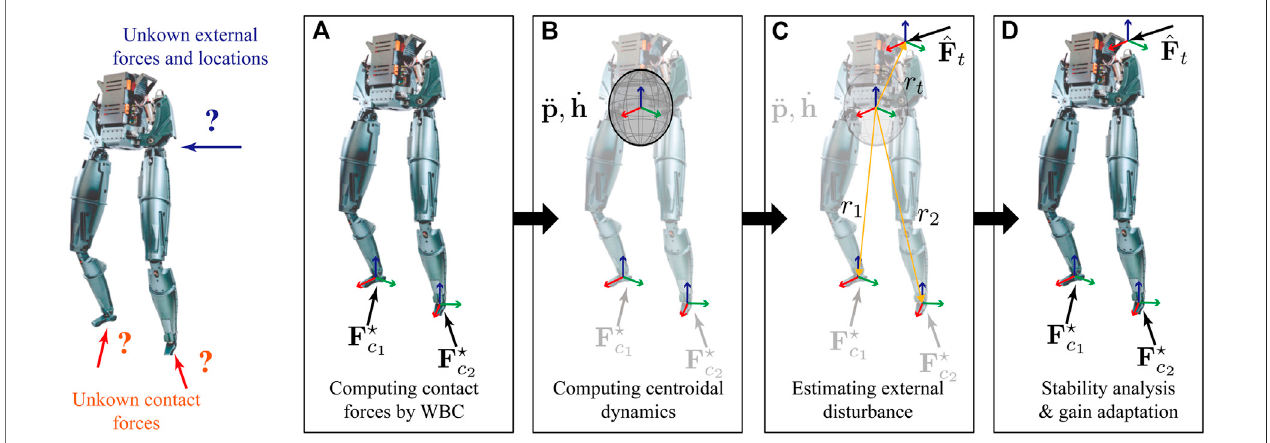
FIGURE2| Ourapproachconsistsof: (A) obtainingcontactforces via WBLC. (B) ComputingCentroidaldynamicsusingthecurrentjointcon fi gurationandvelocity. (C) Estimating unknown external forces with respect to the robot ’ s body frame. (D) Online gain adaptation with stability analysis.